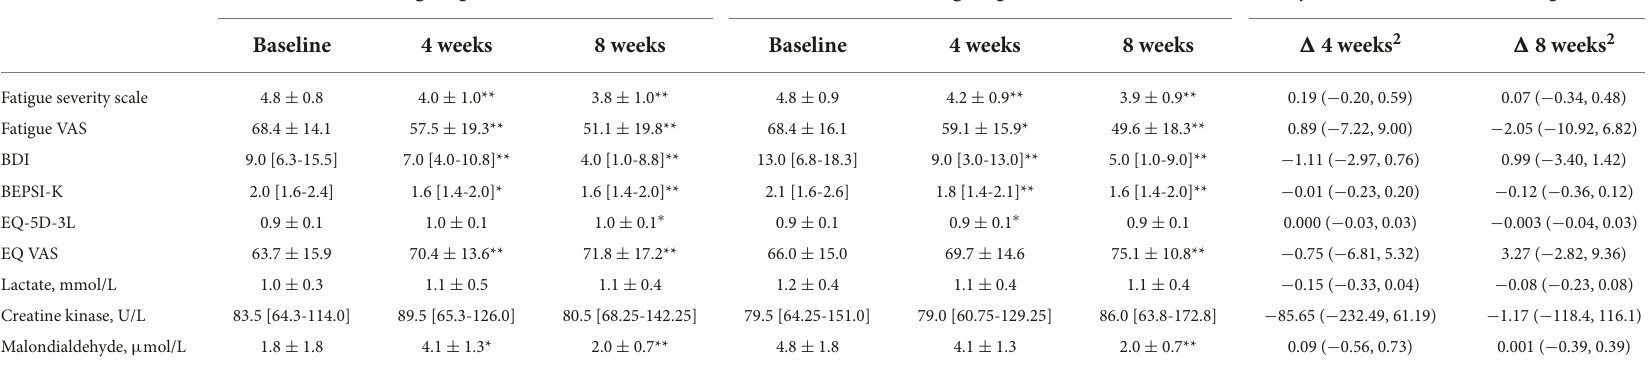
TABLE 3 Primary and secondary outcomes (per protocol population) 1